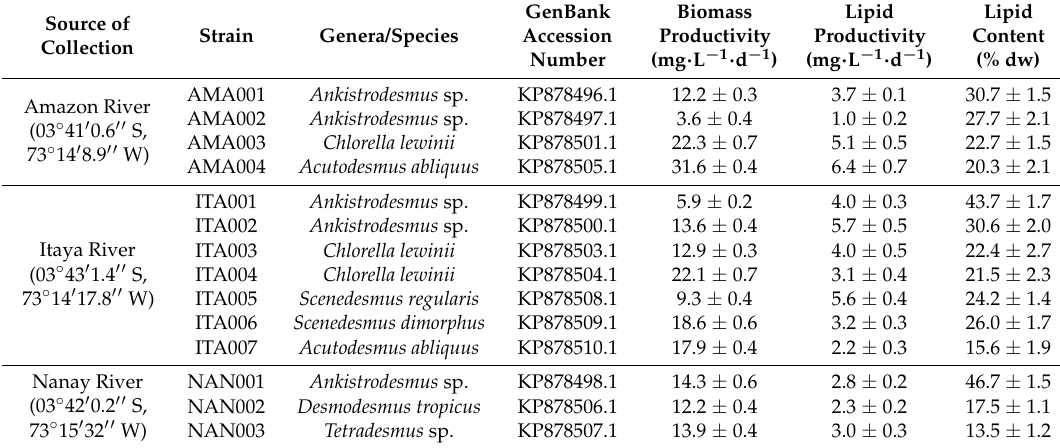
Table 1. Genera, GenBank accession number of ITS2 sequences, biomass productivity, lipid productivity and lipid content of isolated microalgae